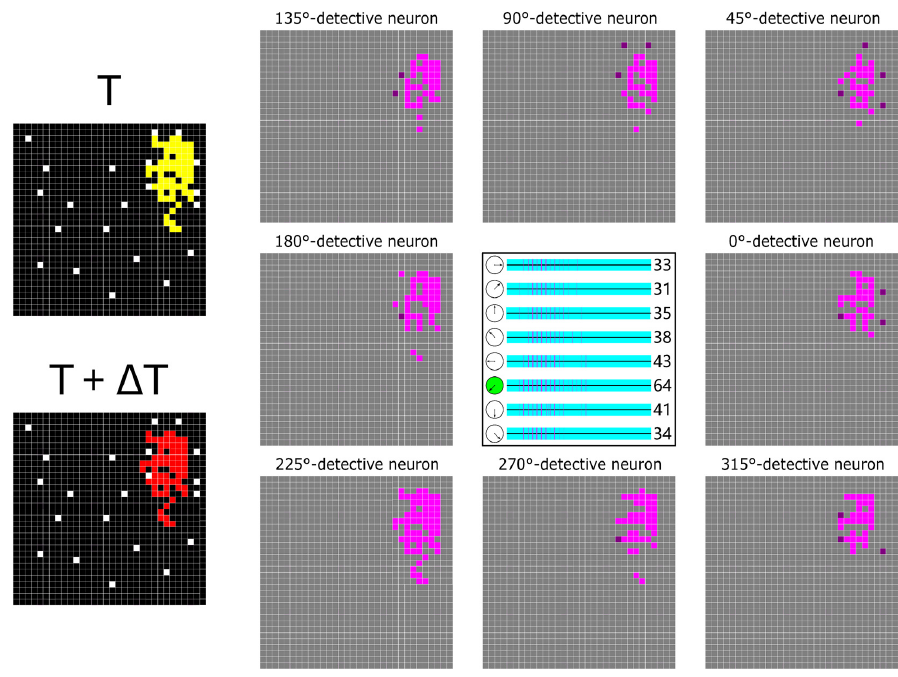
Figure 7. The activation plots of the AVS for 64-pixel object motion direction detection within the background with 2% connected noises.